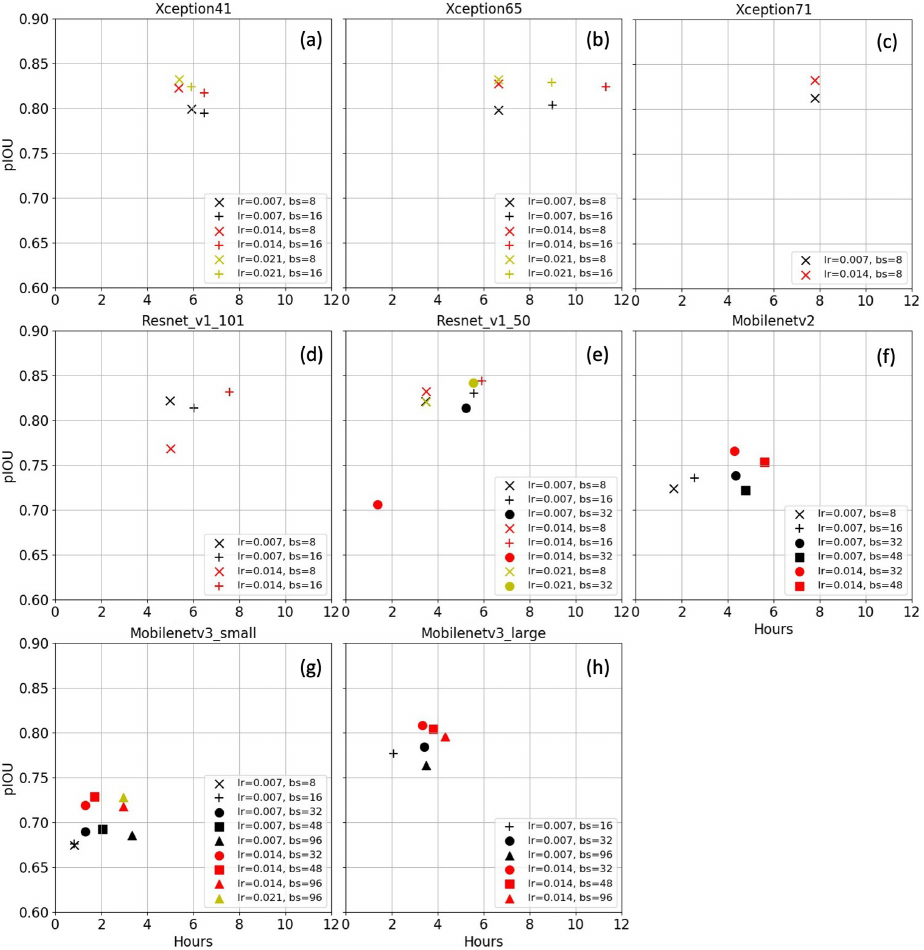
Figure 7. Accuracy of eight backbones and GPU time of different computational backbones used to run the DeepLab slump model. ( a – h ) show the accuracies of different backbones. Accuracy measured as pixel-wise intersection over union (pIOU) on the validation dataset and training time of eight backbones. “lr” is learning rate and “bs” is batch size. Y-axis is pIOU and X-axis